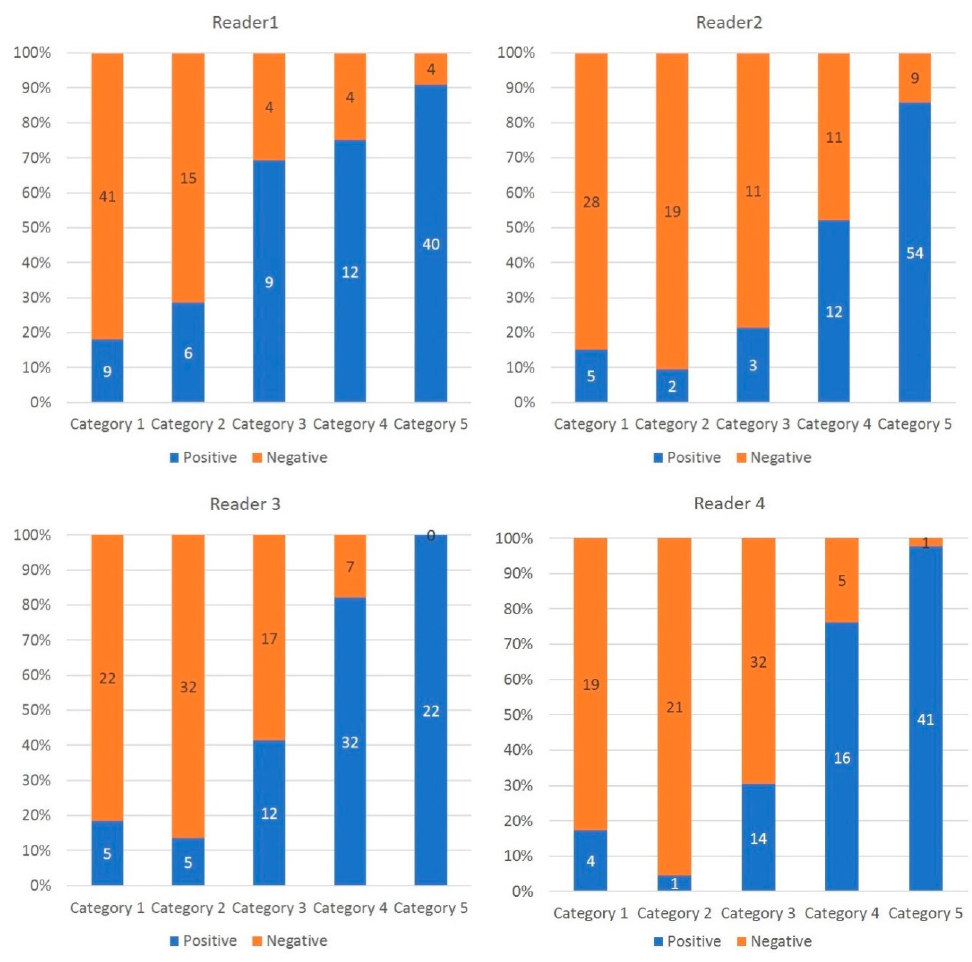
Figure 2. Percentage and number of COVID19 patients per CO-RADS category. The histogram shows the proportion of COVID19 patients per CO-RADS category. The higher the CO-RADS category, the higher the proportion of COVID-19 positive patients.